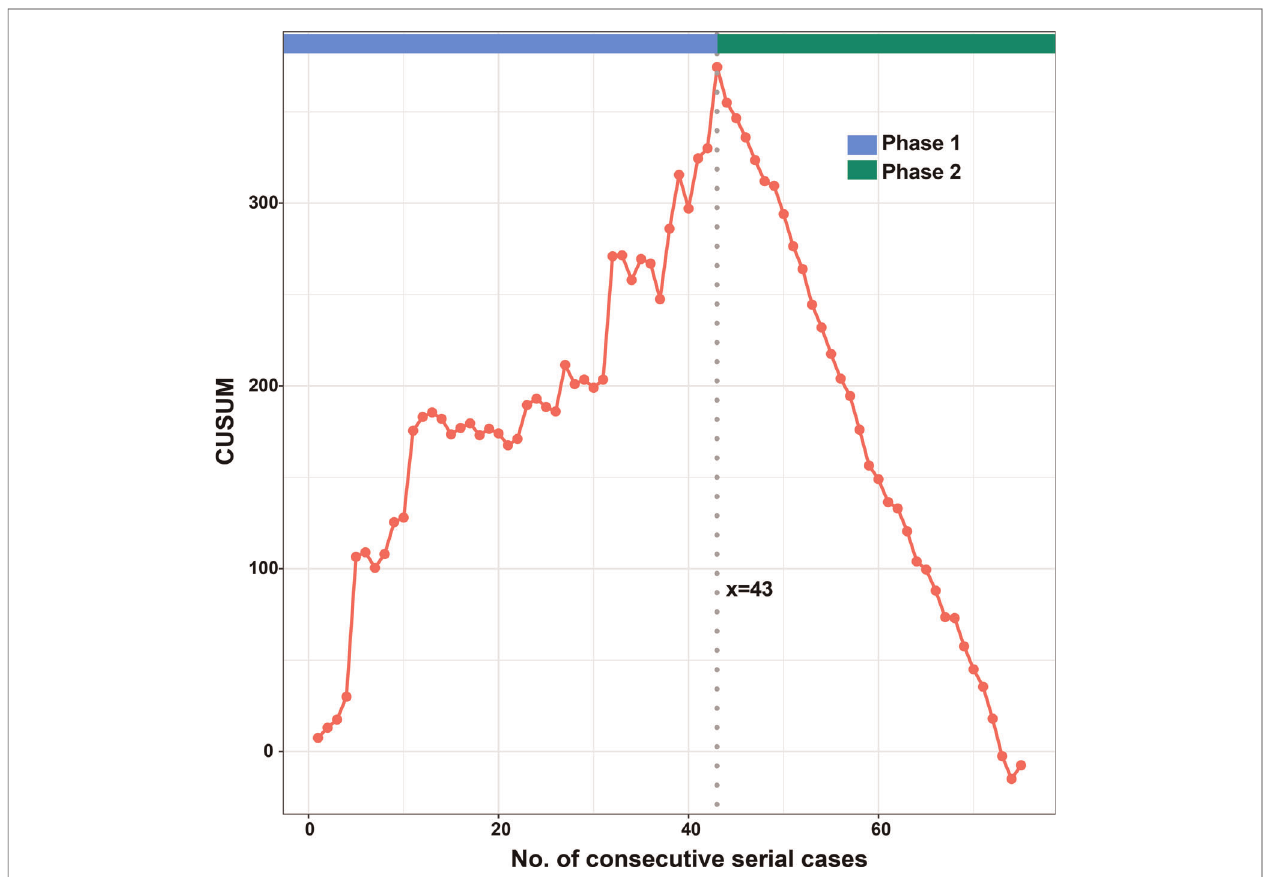
FIGURE 2 | CUSUM analysis of anastomosis